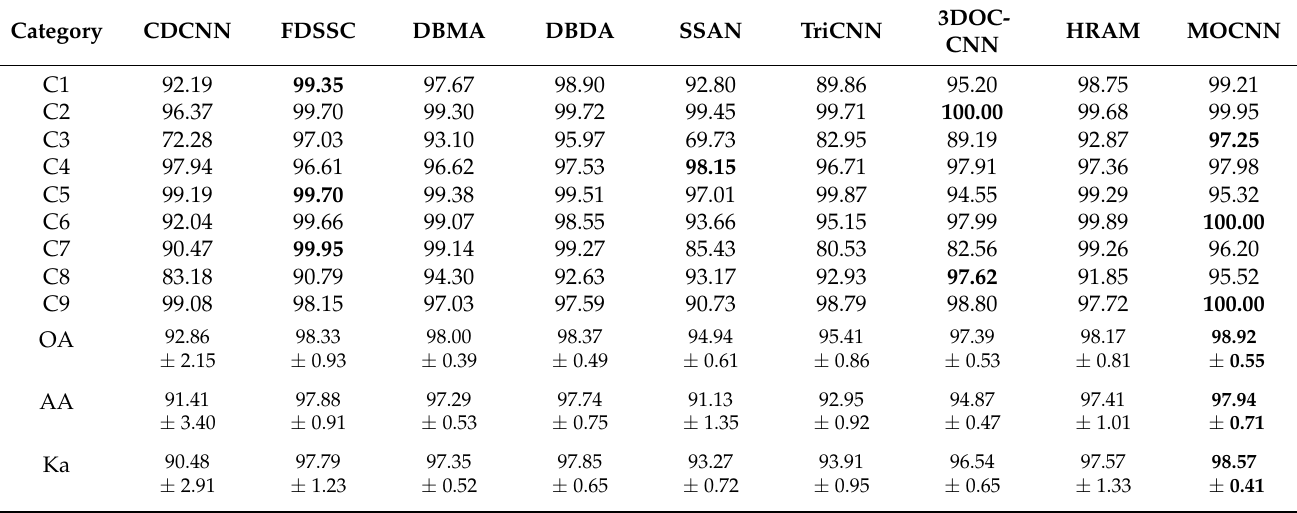
Table 7. Quantitative comparison of the CDCNN [30], FDSSC [31], DBMA [34], DBDA [35], SSAN